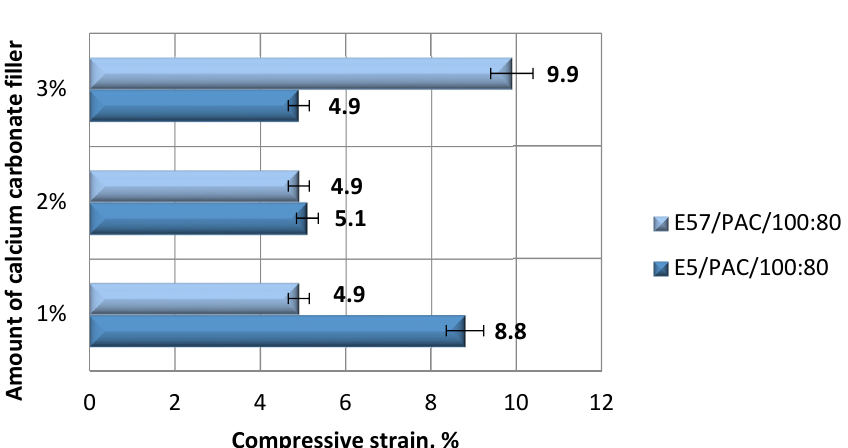
Figure 5. Comparison of the compressive strain between the E5/PAC/100:80 and E57/PAC/100:80 epoxy specimens modified by the calcium carbonate filler.